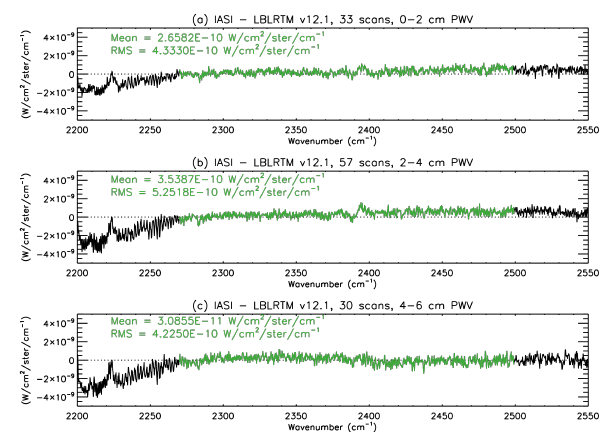
Fig. 10. Mean final (a posteriori) radiance residuals in the CO 2 ν 3 band using LBLRTM v12.1 as in Fig. 7b, but only for profiles with (a) 0 to 2cm, (b) 2 to 4cm, and (c) 4 to 6cm of precipitable water vapor.